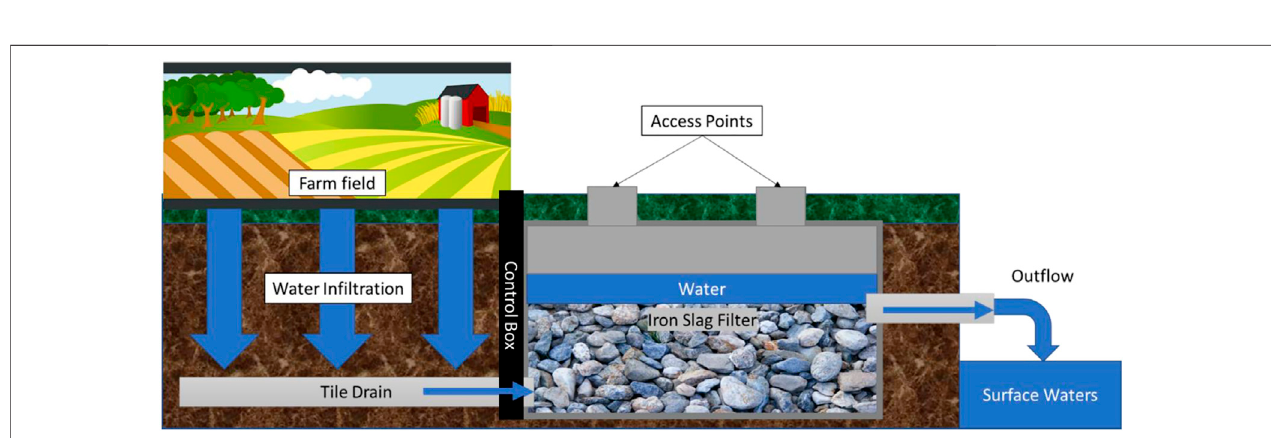
FIGURE 2 | Stylized cross-section of EAF slag fi lters design/function. Figure is not to scale as EAF slag fi lter size is dependent on multiple factors (e.g., size of the tiled fi eld, water velocity from the tile drains, soil type). See text for more detail on how the fi lters function. Image credit: Maggie Oudsema.